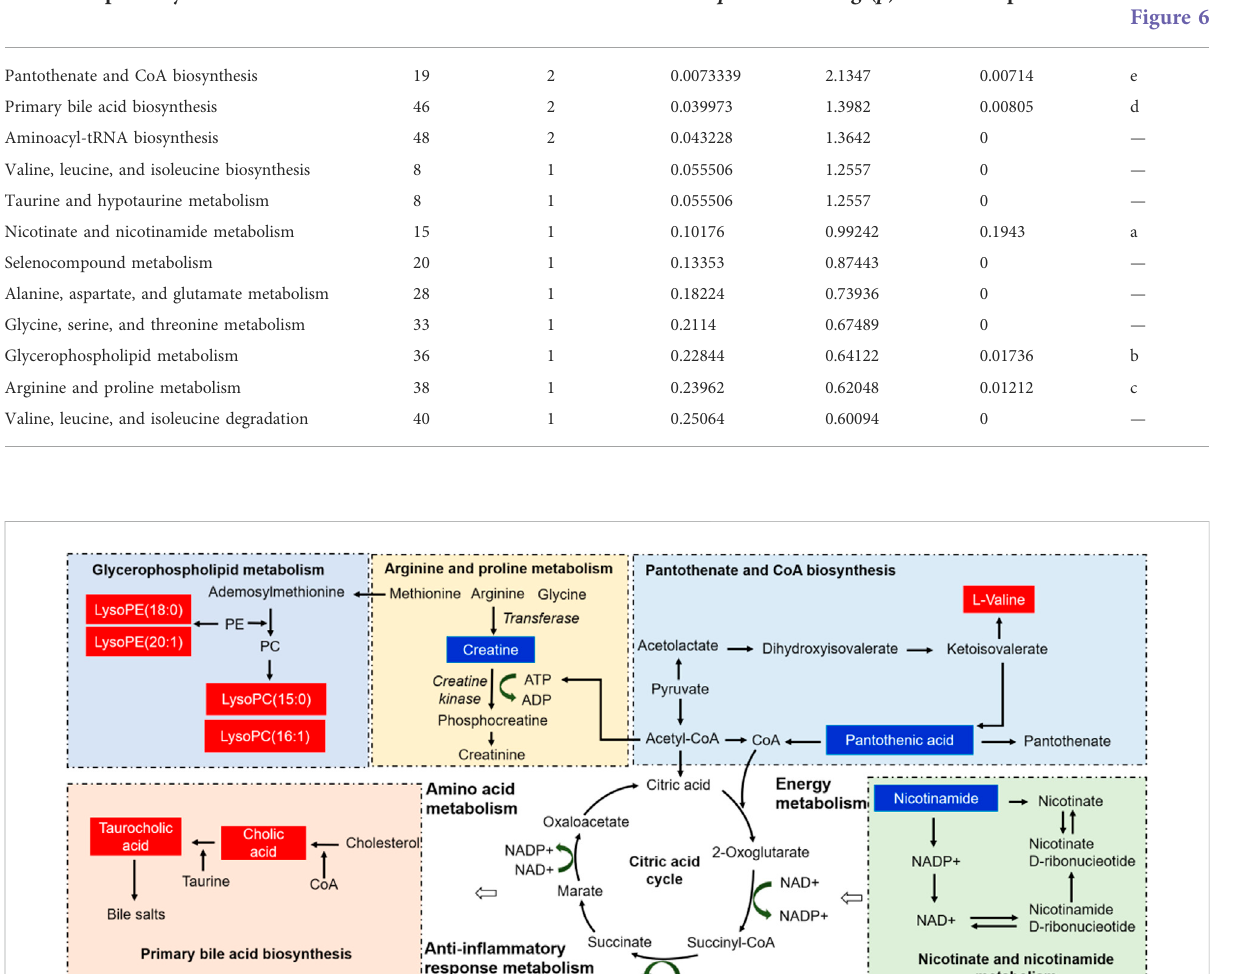
TABLE 2 Summary of metabolic pathways of potential biomarkers. Metabolic pathway